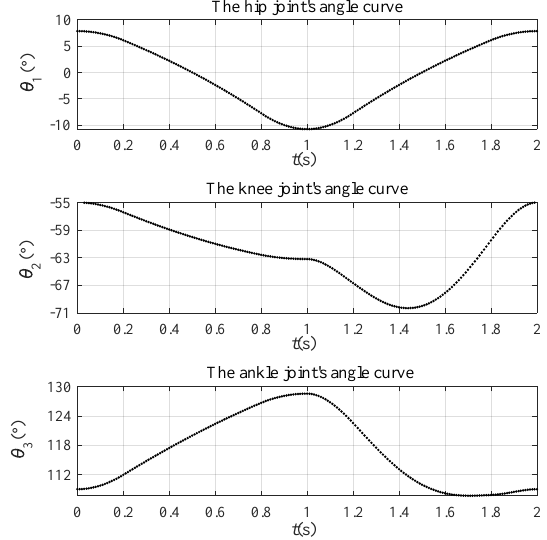
Figure 9. Joints’ angle curve.